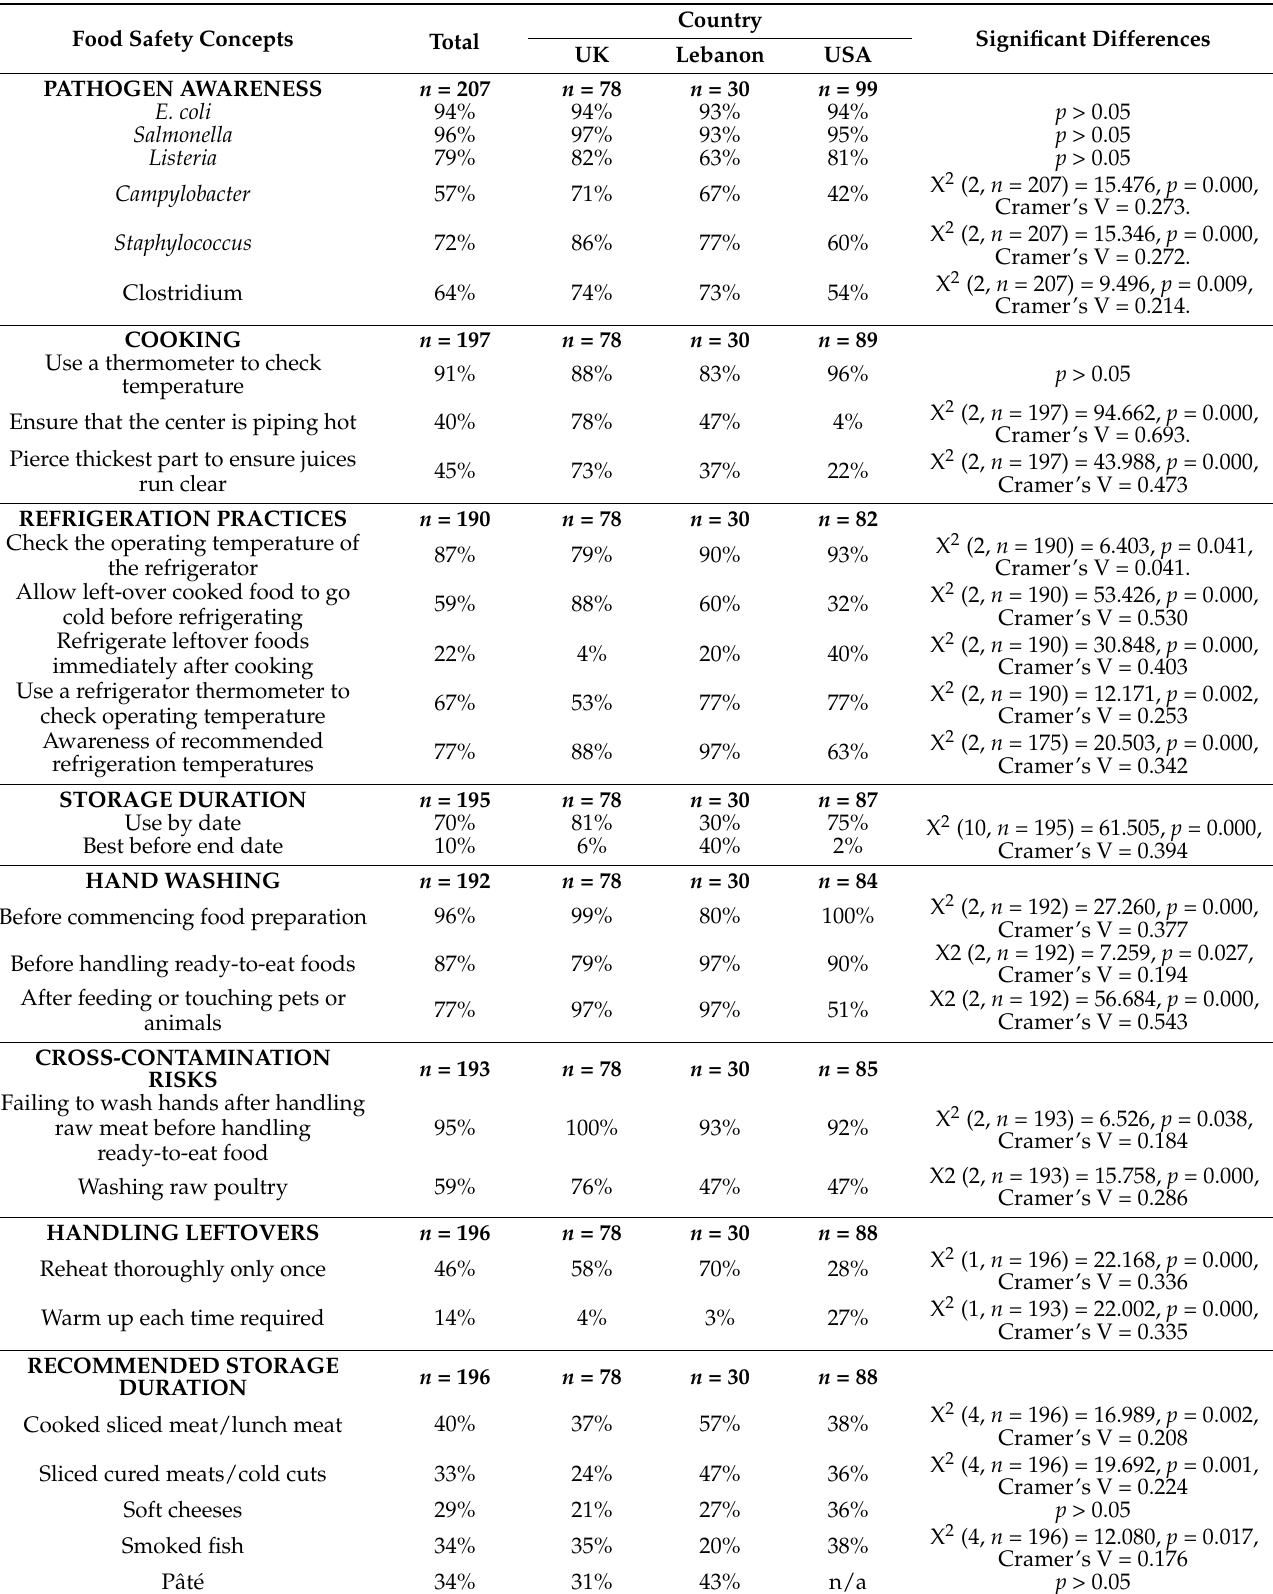
Table 3. Food safety awareness according to dietetic students in United Kingdom, Lebanon and United States. Food Safety